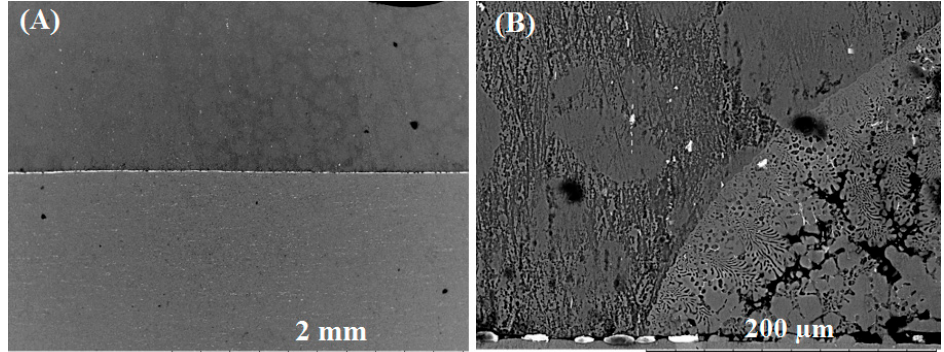
Figure 7. ( A ) SEM micrograph of Mg/Al joint bonded for 10 min using pure-Cu interlayer ( B ) Detail view of the interface.